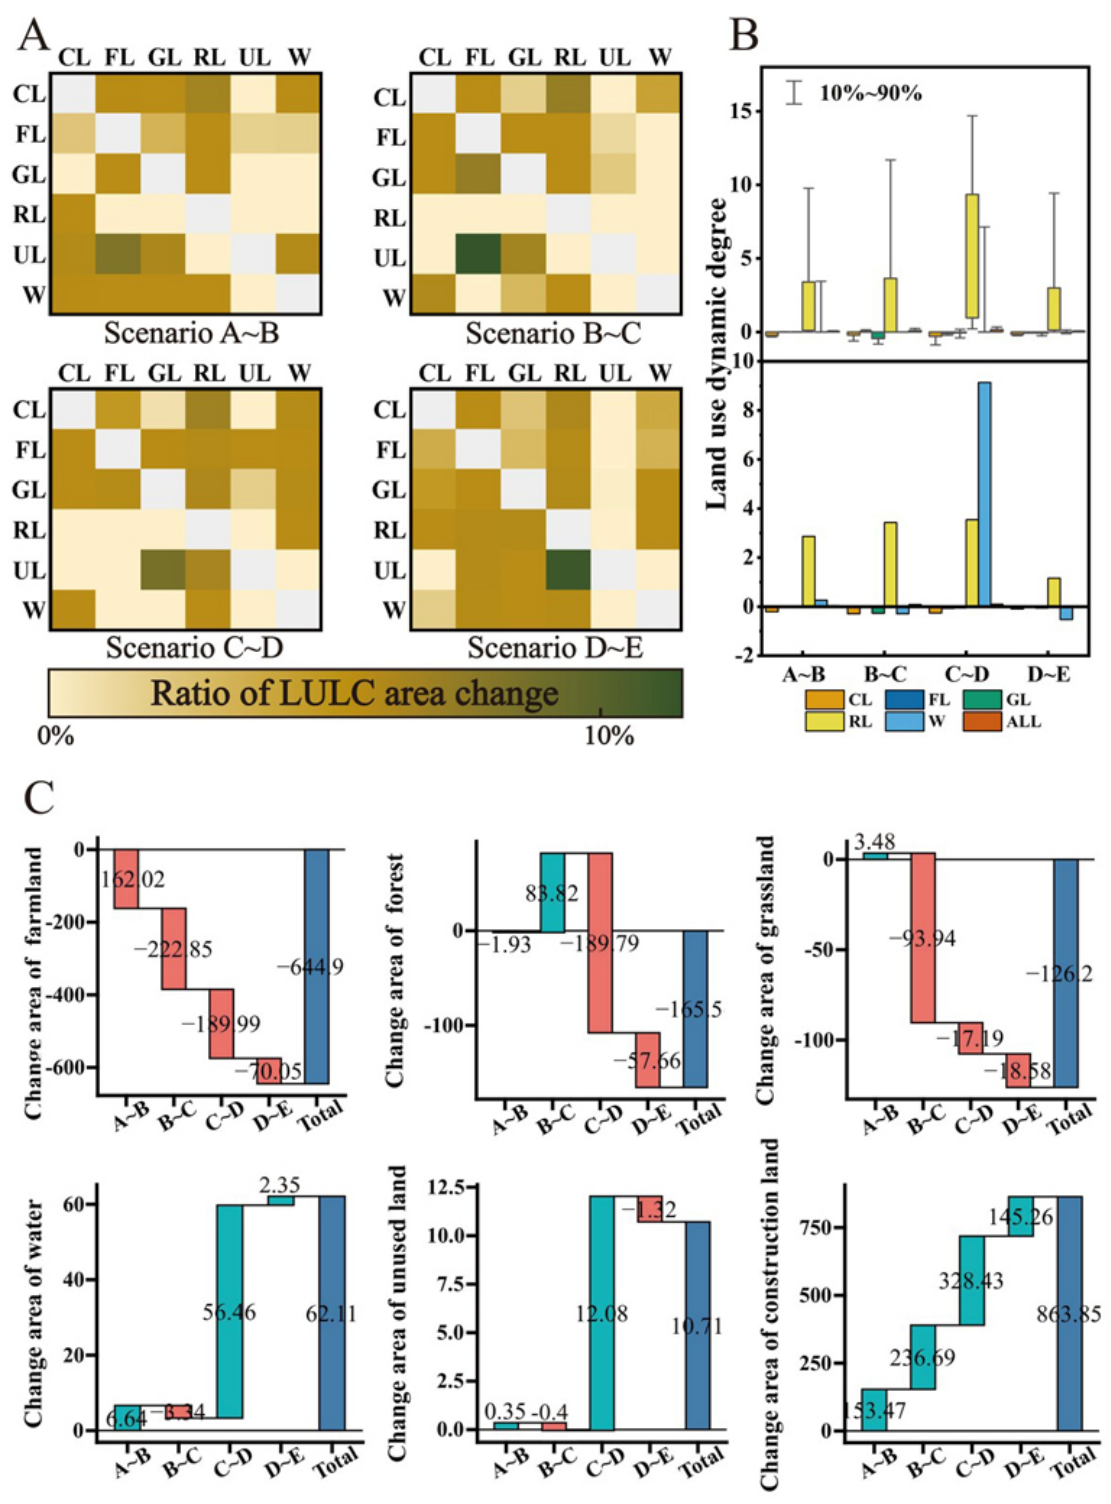
Figure 7. Land use changes in the watershed under the land use change scenario. ( A ) The percentage change matrix for each land use type; ( B ) the distribution and average of dynamic attitudes for each land use type; ( C ) the area of change for each land use type. Note: CL represents cultivated land; FL represents forest; GL represents grassland; RL represents construction land; W represents water.